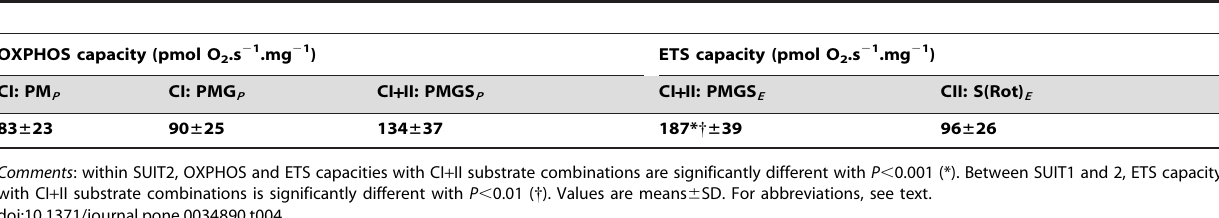
Table 5. Respiratory parameters from substrate-uncoupler-inhibitor titration protocol 2 (SUIT2) applied on equine permeabilized fibres of triceps brachii : flux control ratio ( FCR , with normalization for CI + II E ) and substrate control ratio ( SCR , assuming CII E = CII P ); ( N =15; trained horses matched with SUIT1 and SUIT3 protocols).